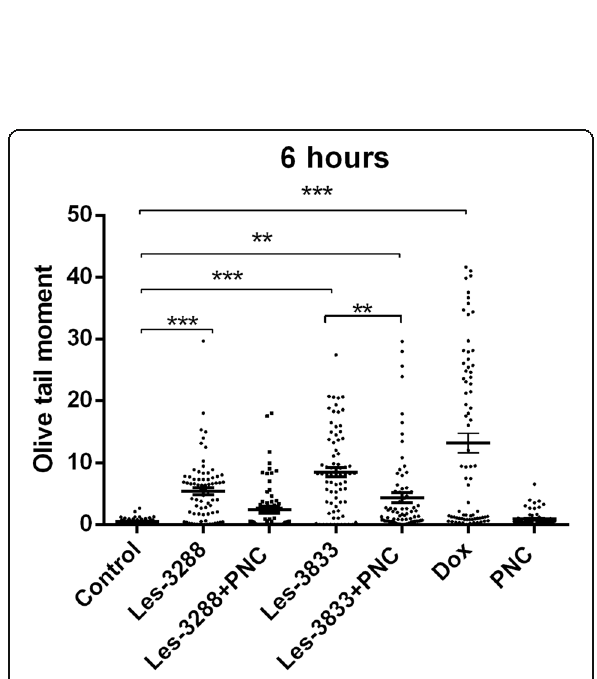
Fig. 11 DNA damage was evaluated using the Olive tail moment in rat glioma C6 cells treated for 6 h with experimental antineoplastic compounds used at a 0.5 μ g/mL concentration. * P ≤ 0.05; ** P ≤ 0.01; *** P ≤ 0.001. PNC, polymeric nanocarrier; Dox,